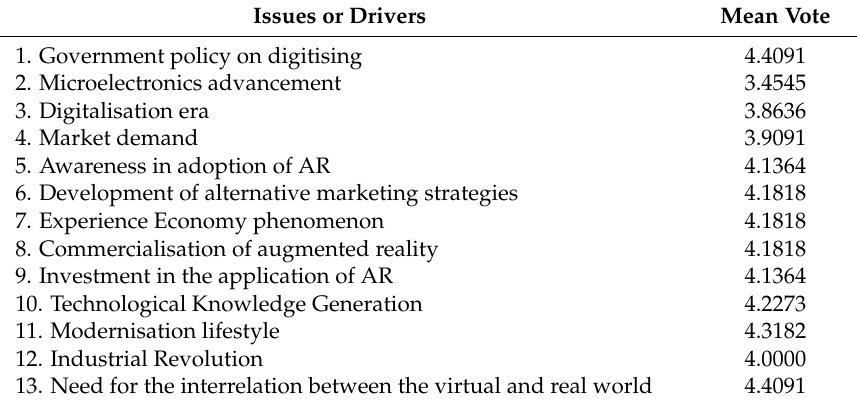
Table 1. Mean vote of the merged issues or drivers on the level of importance.